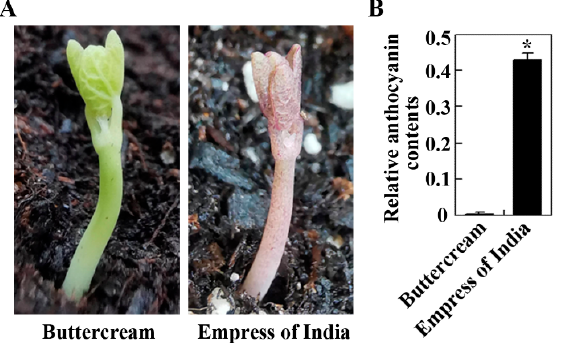
Figure 1. Anthocyanin accumulation in seedlings of the “Empress of India” and the “Buttercream” nasturtiums. ( A ) Seven-day-old soil-grown seedlings of the “Buttercream” and the “Empress of India” varieties. Pictures were taken using a digital camera. ( B ) Relative anthocyanin contents in the seedlings of the “Buttercream” and the “Empress of India” varieties. Data represent the mean ± standard deviation (SD) of two biological repeats. * Significantly different from the “Buttercream” nasturtium ( p = 0.001).